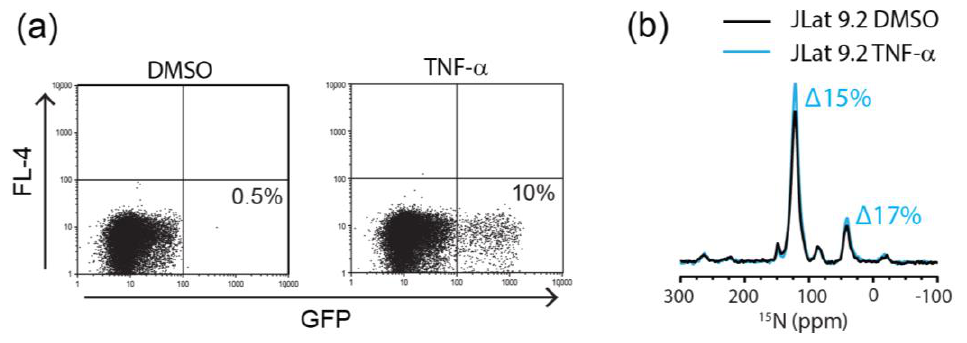
Figure 4. Characterization of the HIV production in JLat 9.2 cells. ( a ) Flow cytometry of the JLat 9.2 cells treated with 1% DMSO (vehicle control) or TNF- α . Plots are gated on live cells with the total percentage of GFP + cells indicated in each plot (bottom right quadrant). ( b ) 15 N CPMAS-DNP spectra of 1% DMSO (black line)- or TNF- α (blue line)-treated 15 N-labeled JLat 9.2 cells. Spectra were acquired at 7.05 T and 95 K with 197.674 GHz microwave irradiation, 4.5 kHz MAS and 2048 transients.